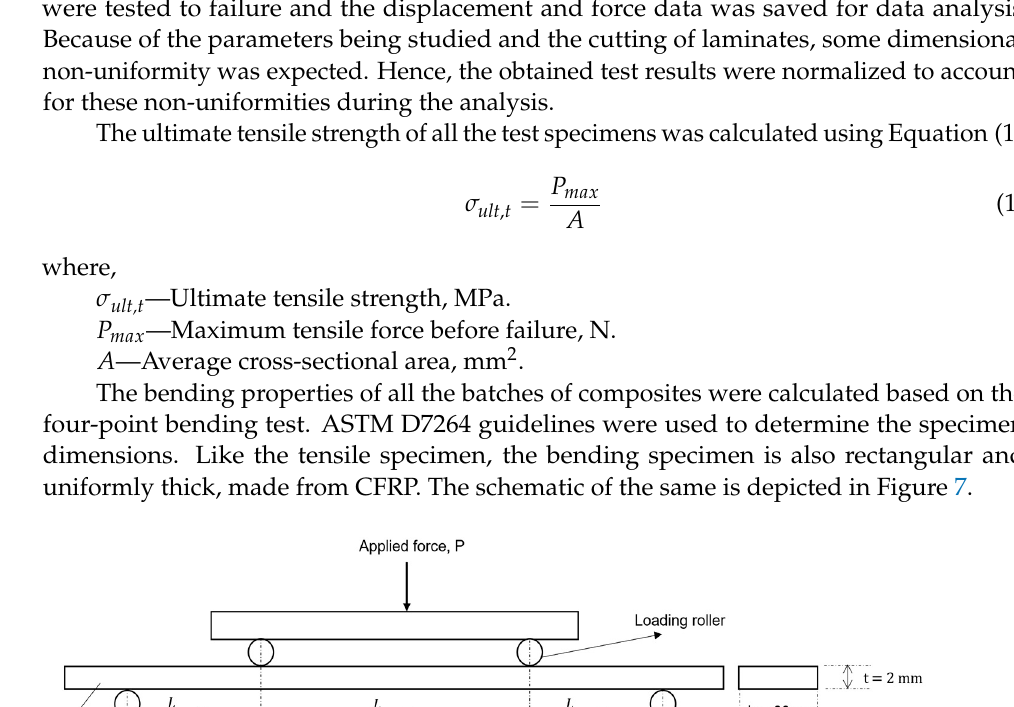
Figure 6. Tensile specimen schematic.